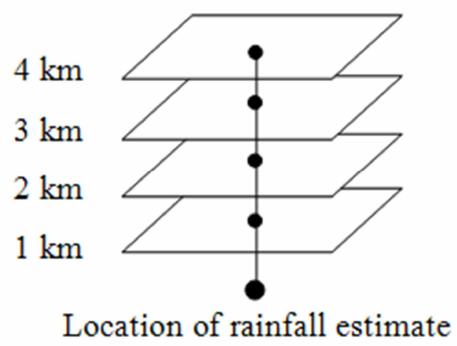
Fig. 3. Data locations for 4 point input F IG . 3: Data locations for 4 point input vector.